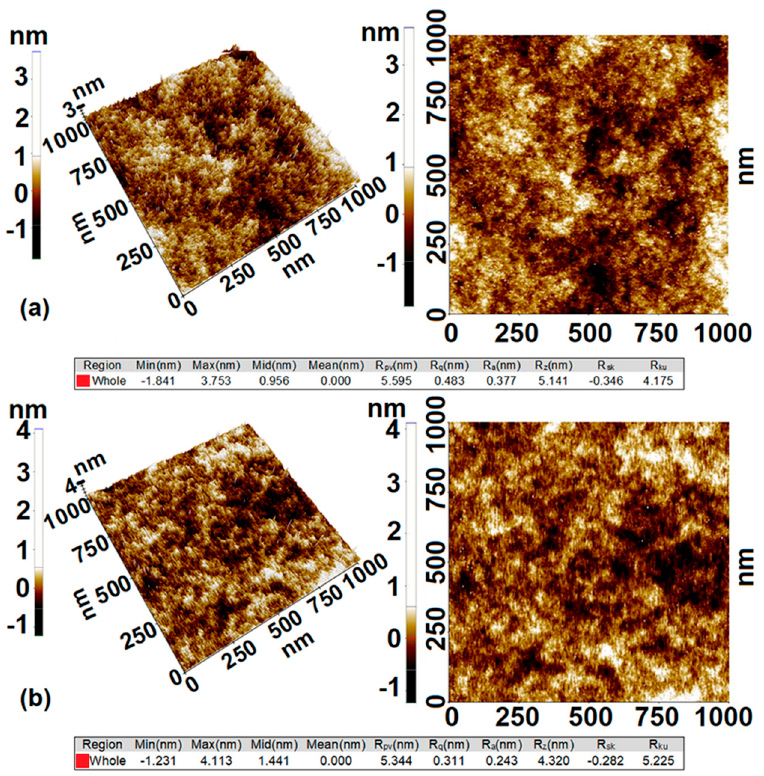
Figure 3. AFM images of G5 hybrid films at 25% ( a ) and 50% ( b ) DMDES loadings.